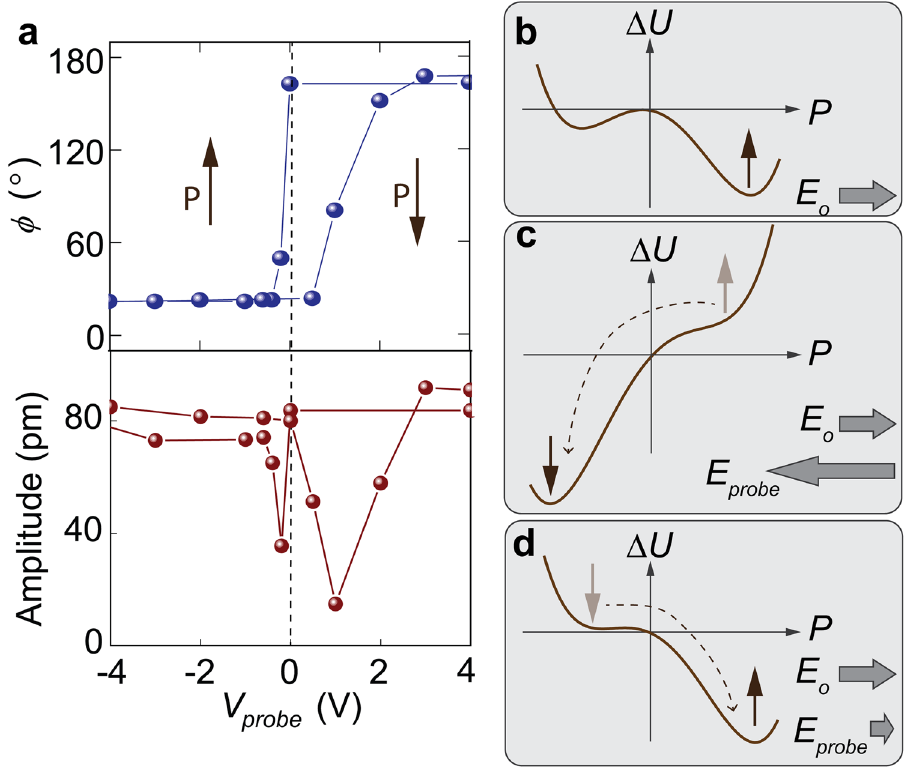
Figure 4. Asymmetry in ferroelectric hysteresis loop induced by built-in field. ( a ) Hysteresis of PFM phase and amplitude as a function of poling probe voltage. ( b–d ) Illustrations of the ferroelectric double well potential and polarization states affected by the built-in field ( E ) and external probe 0